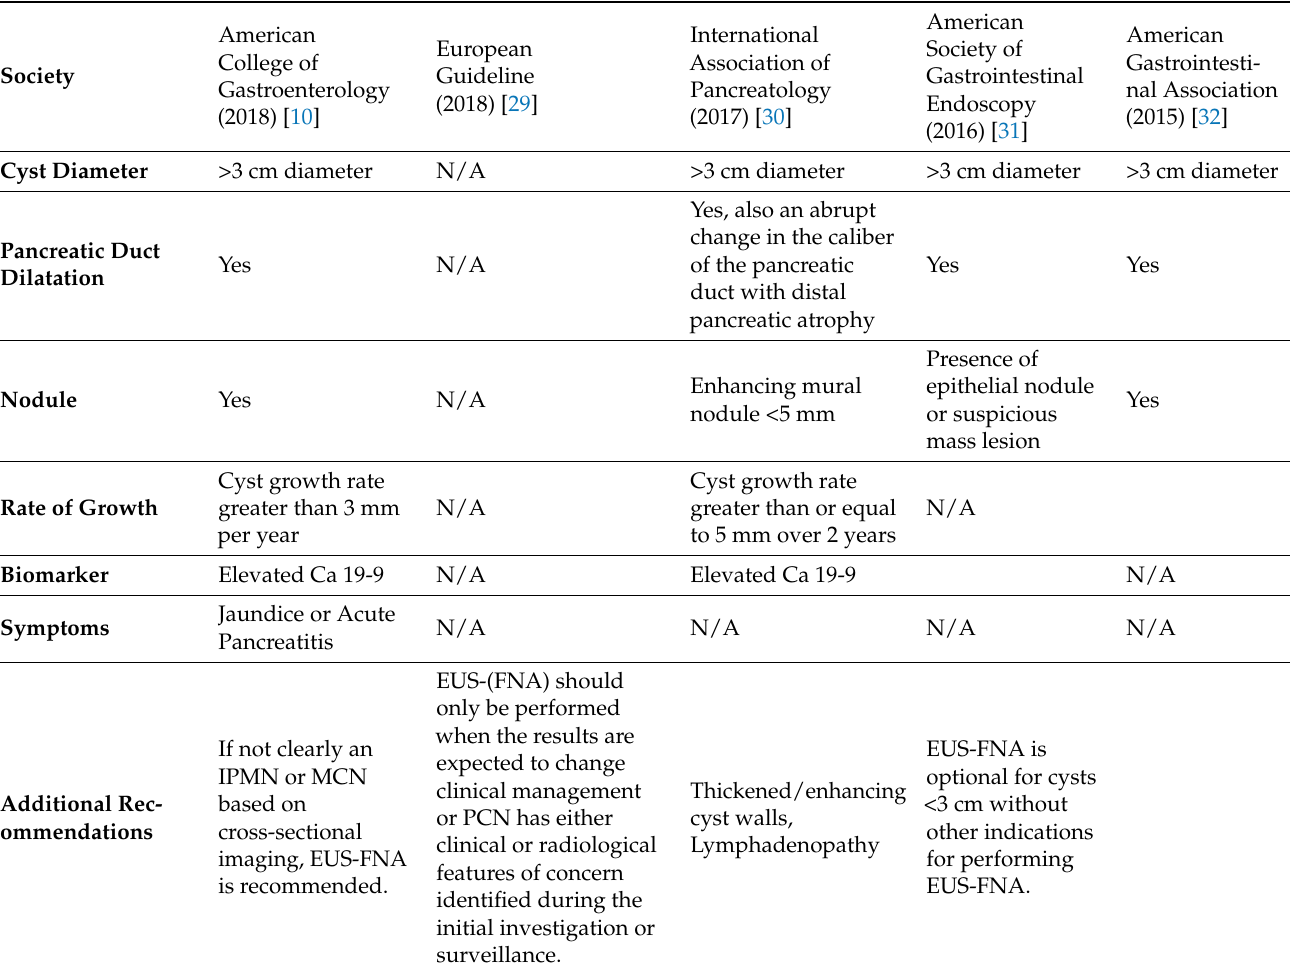
Table 1. Indications for Endoscopic Ultrasound of Pancreatic Cystic